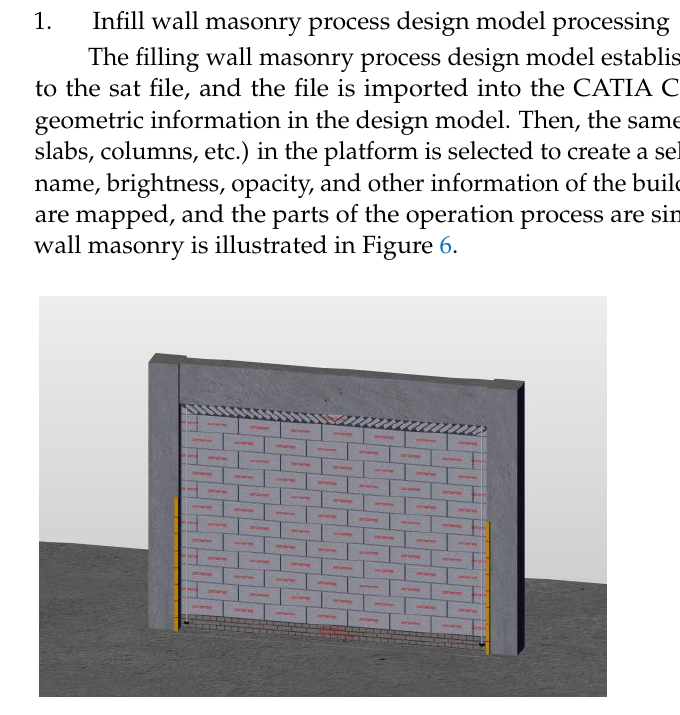
Figure 6. Treatment of the infilled wall masonry model.